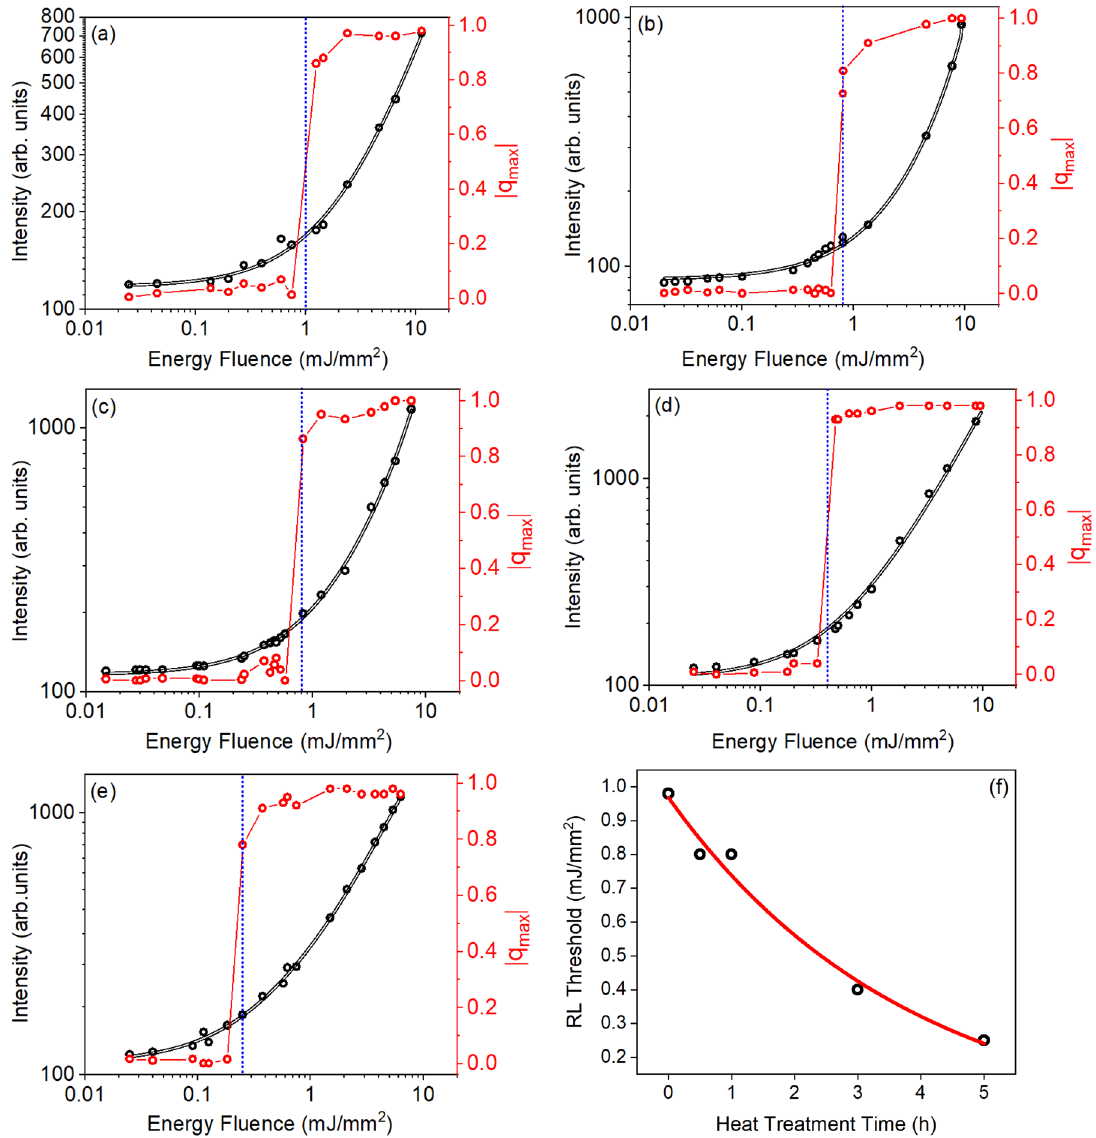
Figure 9. Modulus of the maximum Parisi overlap parameter (red curves) and PL intensity versus EFE at 1068 nm (black curves) for Nd 3+ doped GPM samples. ( a ) GPM; ( b ) GPM05; ( c ) GPM1; ( d ) GPM3; ( e ) GPM5; ( f ) EFE th as a function of heat treatment time. The dashed blue line indicates the EFE th for each